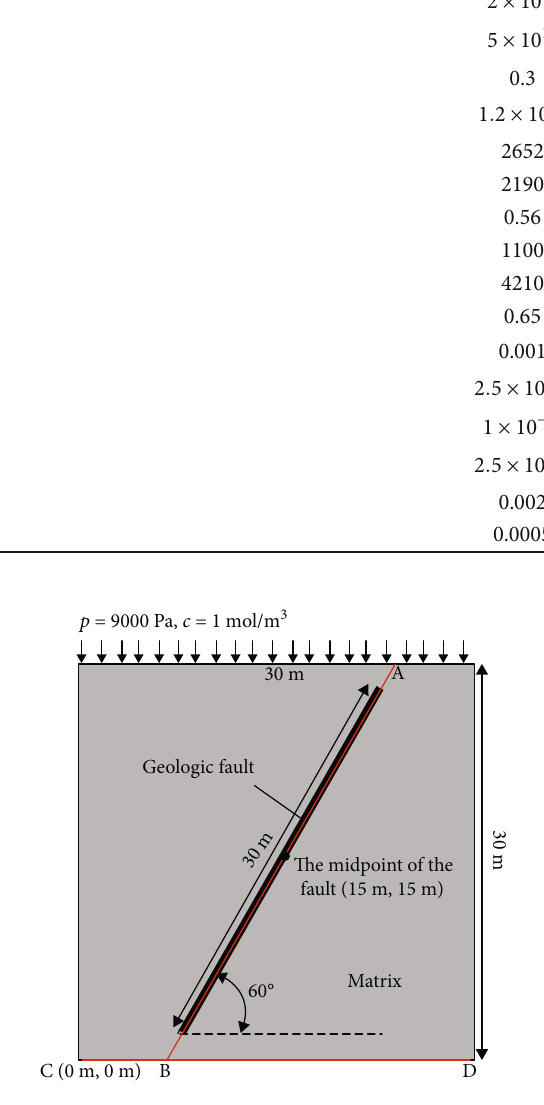
Figure 2: Geometry of the MF